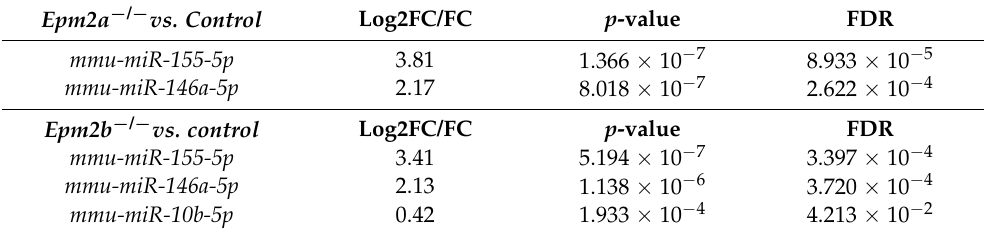
Table 1. Differentially expressed microRNAs after small RNA-seq analysis. Epm2a −/− vs. Control